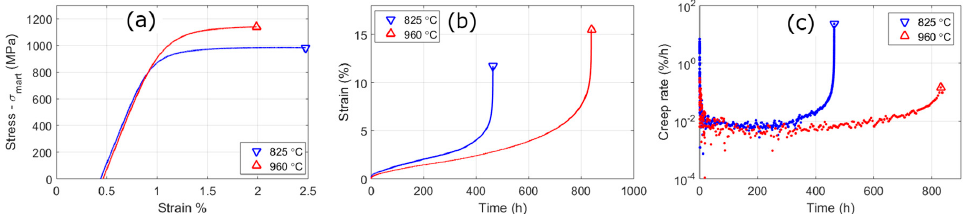
Figure 9. ( a ) Room-temperature tensile stress-strain curves (where σ mart is the predicted martensite strengthening); ( b ) creep-curves to rupture and ( c ) creep-rate curves. Creep samples are measured